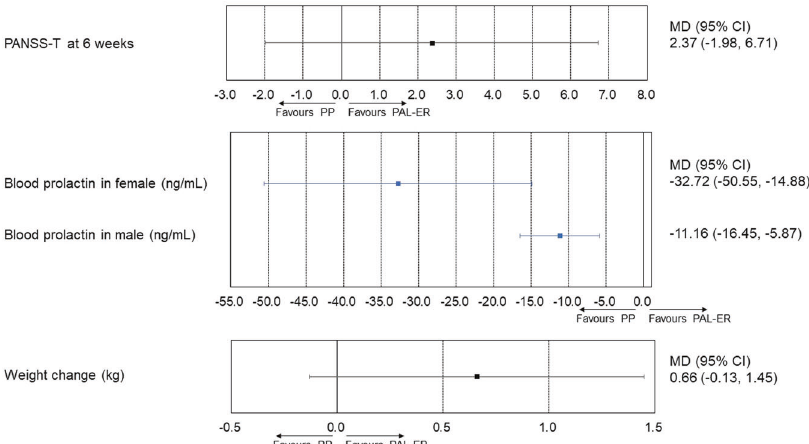
Fig. 1 The results of the network meta-analysis: continuous variables. Error bar represents 95% CI. PP was compared with PAL-ER. Colors indicate the presence or absence of a signi fi cant difference: blue, PP was superior to PAL-ER; black, PP was similar to PAL-ER. 95% CI, 95% con fi dence interval; MD, mean difference; PAL-ER, paliperidone extended-release; PANSS-T, total score of the Positive and Negative Syndrome Scale total score; PP, paliperidone